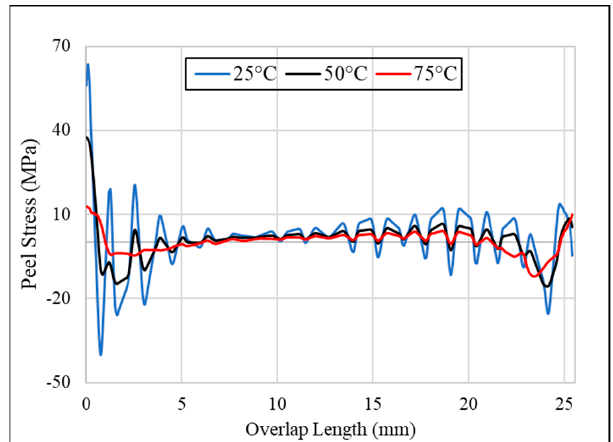
Figure 17. Peel stress distribution at location D of SLJ with Al 2 O 3 nanoparticles in the adhesive at different temperatures.